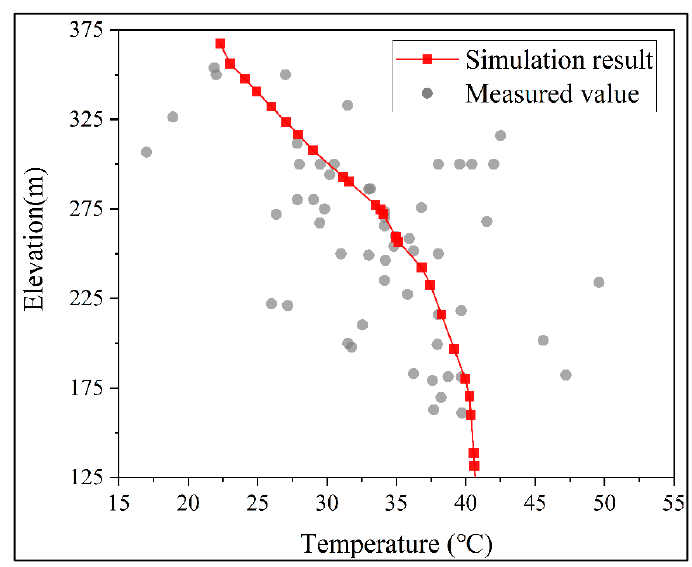
Figure 15. Comparisons between simulated temperature distribution extracted from Line 1 in Figure 14 and the measured values near the dam site shown in Section 2, Figure 3.